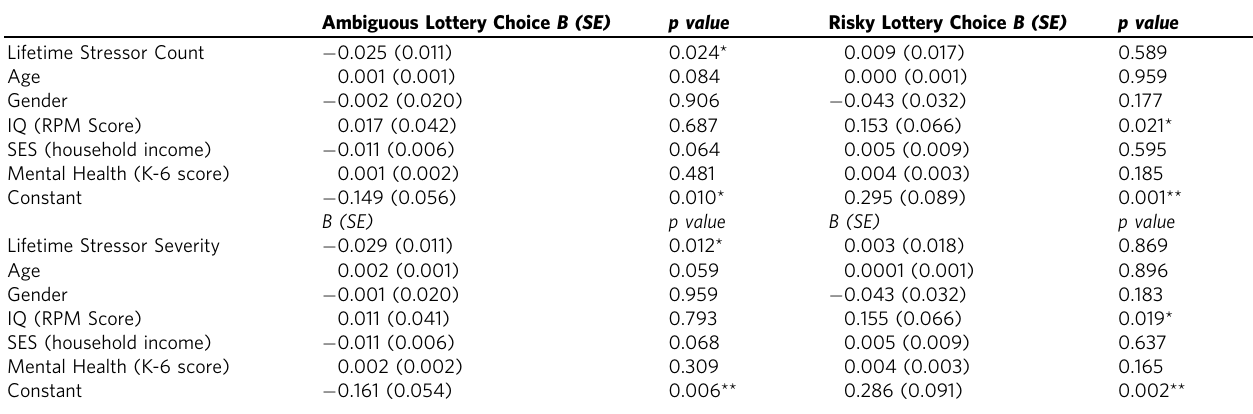
Table 2 Total lifetime stressor exposure and ambiguous vs. risky lottery choices (Study